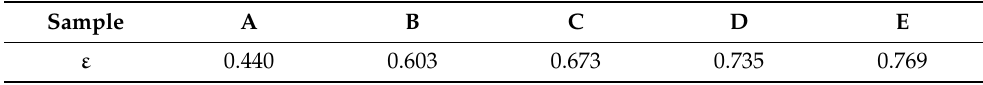
Table 1. Porosity of the different brick